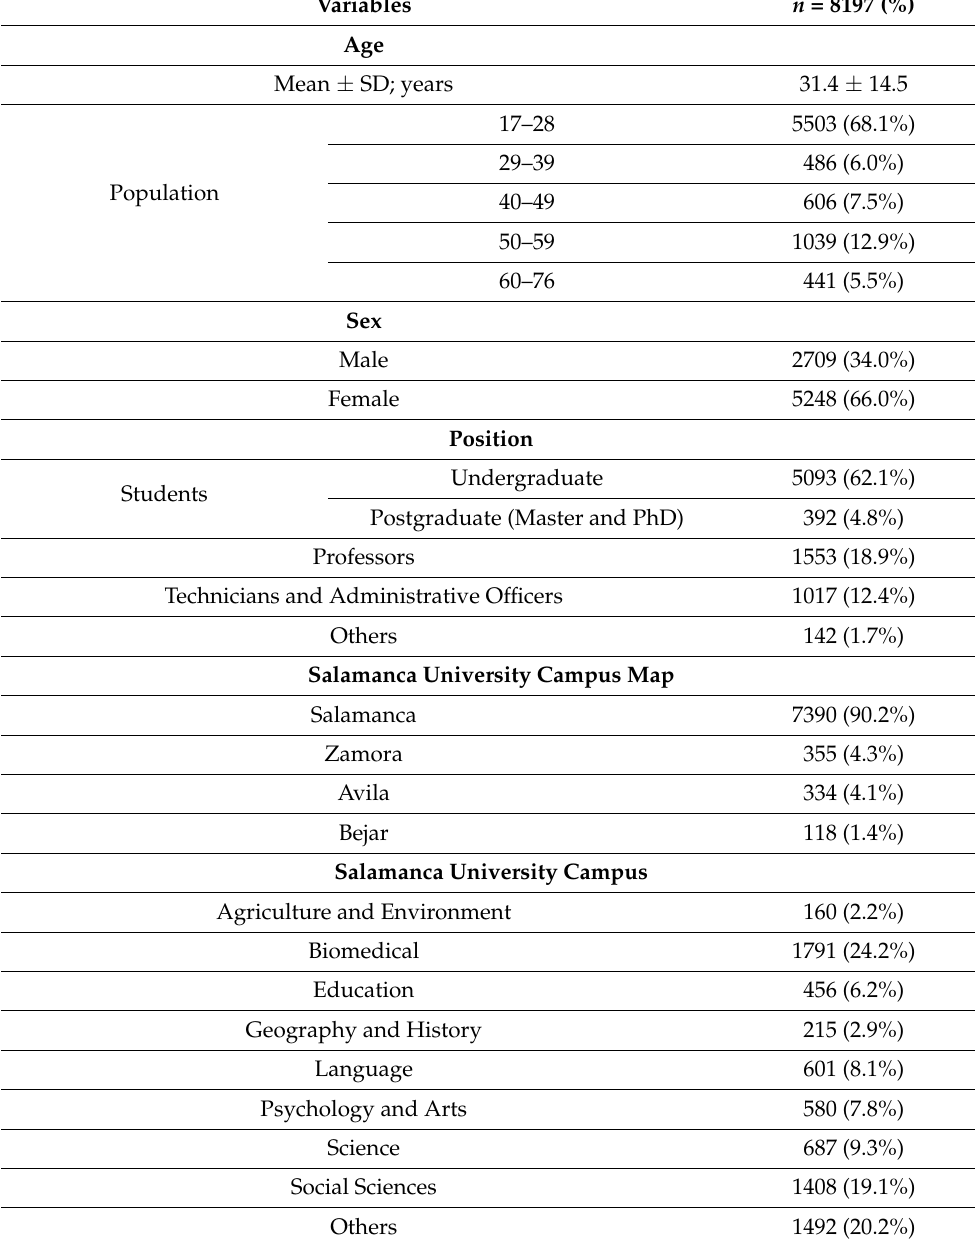
Table 1. Main data according to the different demographic variables selected: age, sex, categories, location campus and